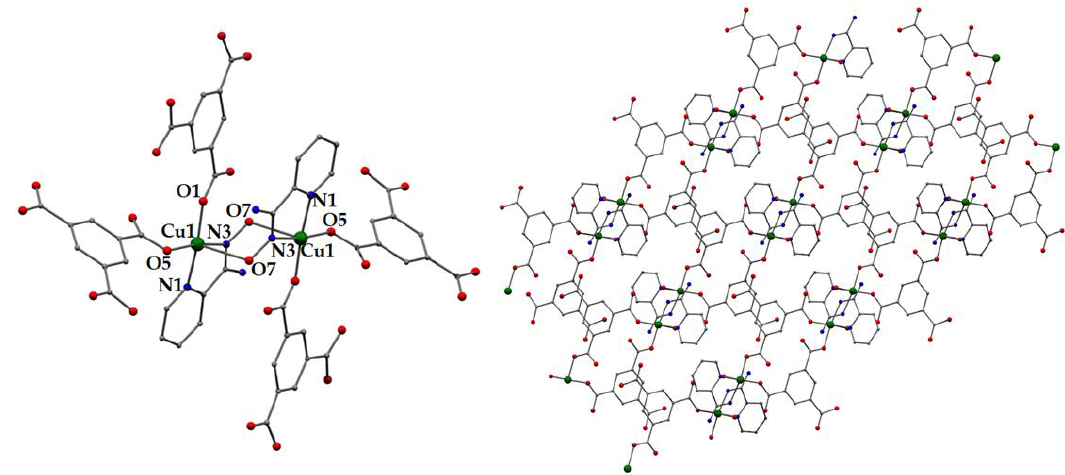
interactions ( right ). Colour code: Zn II , cyan; N, blue; O, red; C, grey.